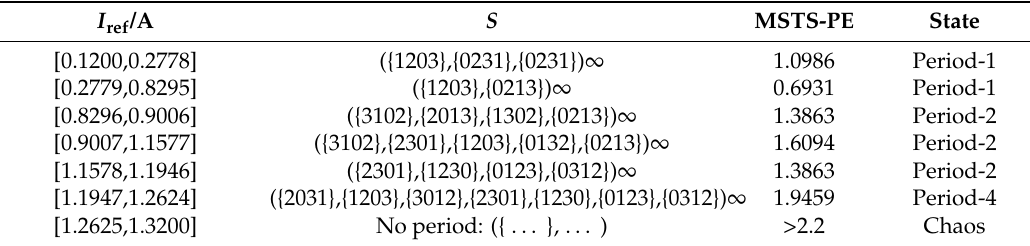
Table 1. Permutation sequence and permutation entropy of the buck converter as reference current I ref changes.